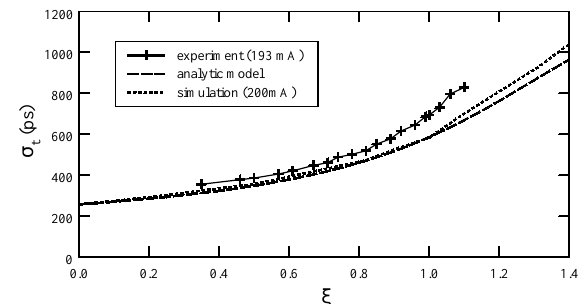
FIG. 10. Bunch length determined from experiment, analytic modeling, and simulations, for active Landau-cavity operation with the Aladdin lattice. The parameter j is proportional to the Landau-cavity voltage, equaling unity for an optimally length- ened